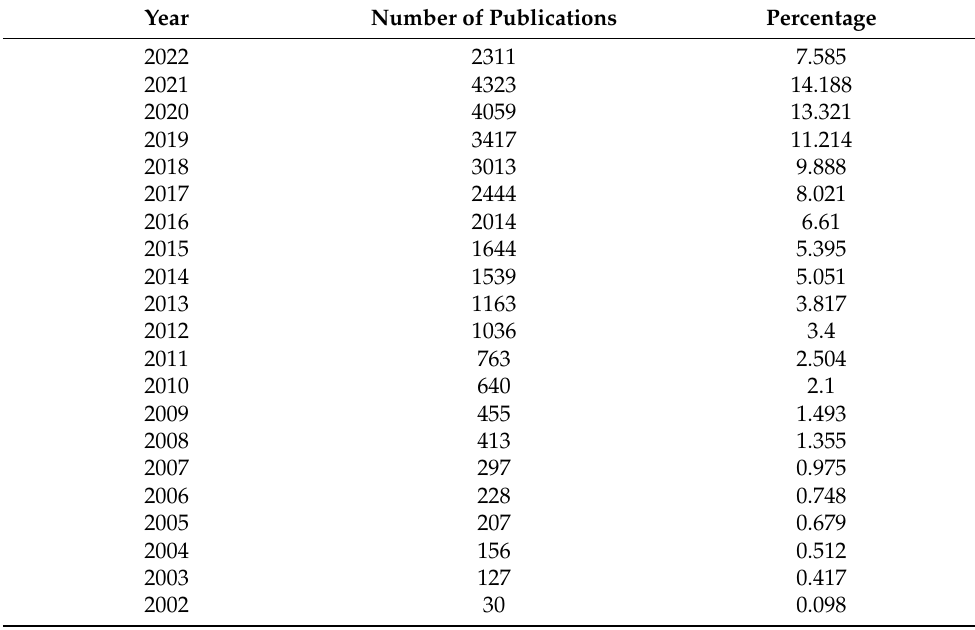
Table 2. Number of publications on building energy consumption.